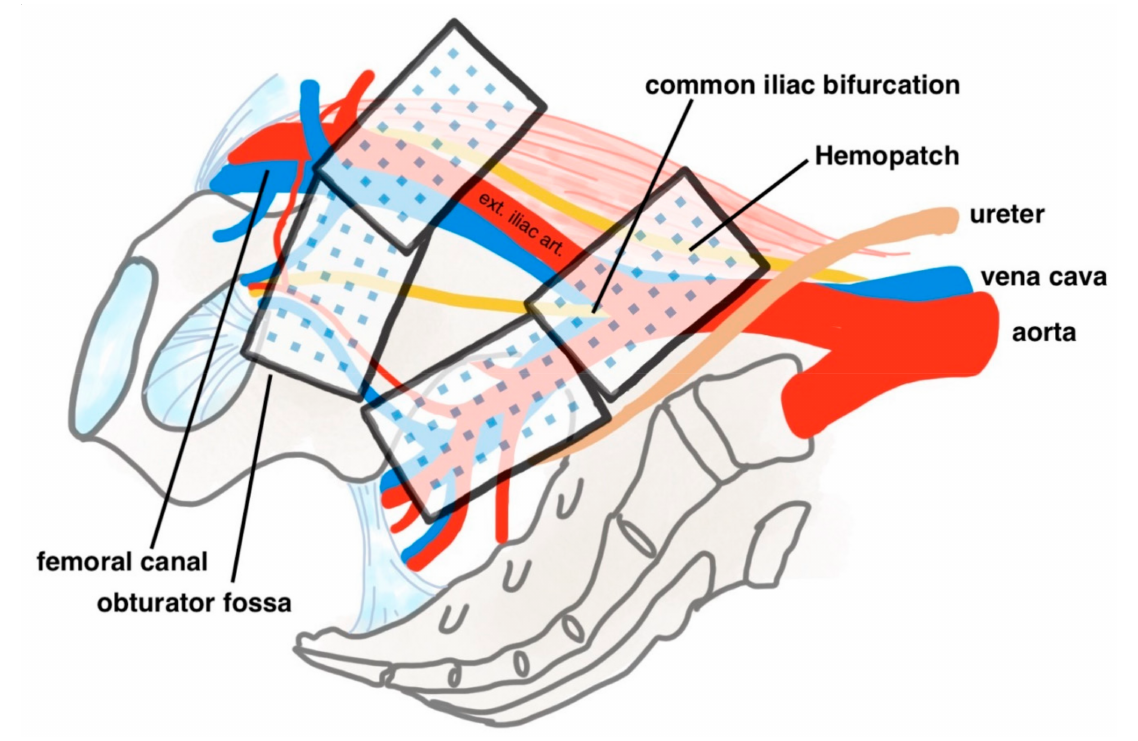
Figure 1. Hemopatch placement position diagram. Ext. iliac art. = external iliac